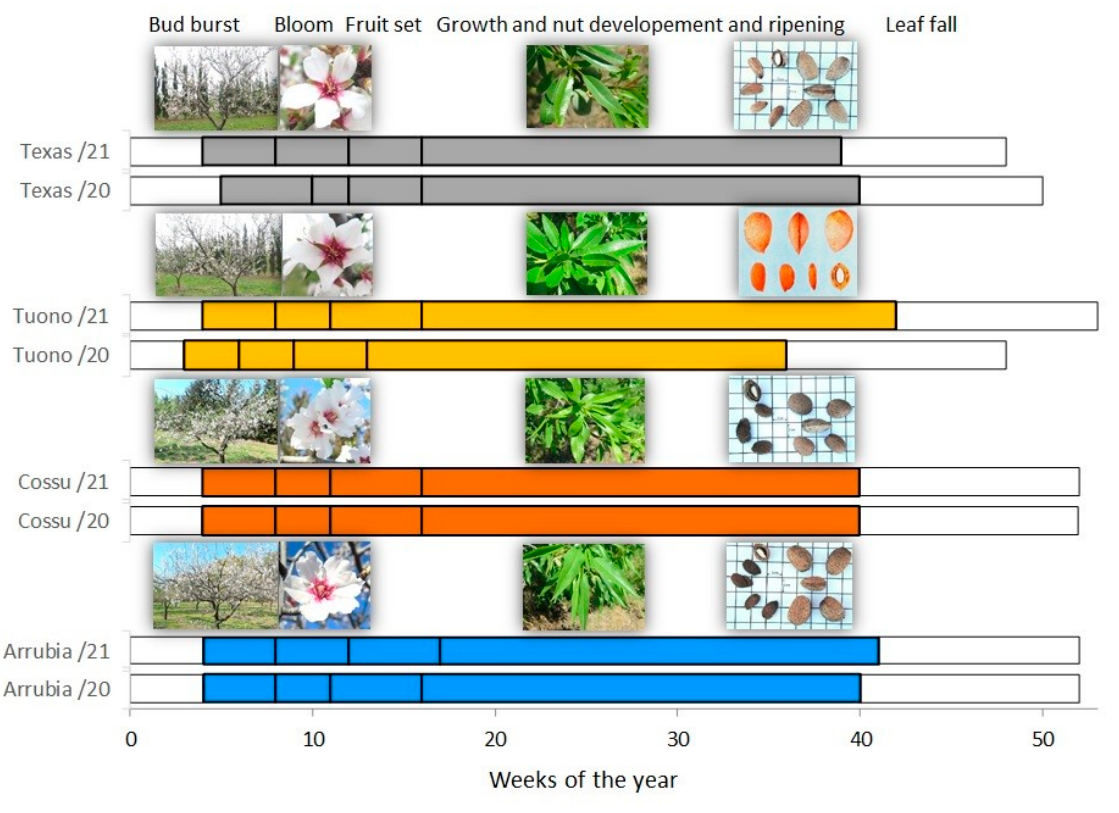
Figure 1. Diagram of the phenological courses of ‘Arrubia’, ‘Cossu’, ‘Tuono,’ and ‘Texas’ during the growing seasons 2020 and 2021 in the studied field collection orchard.